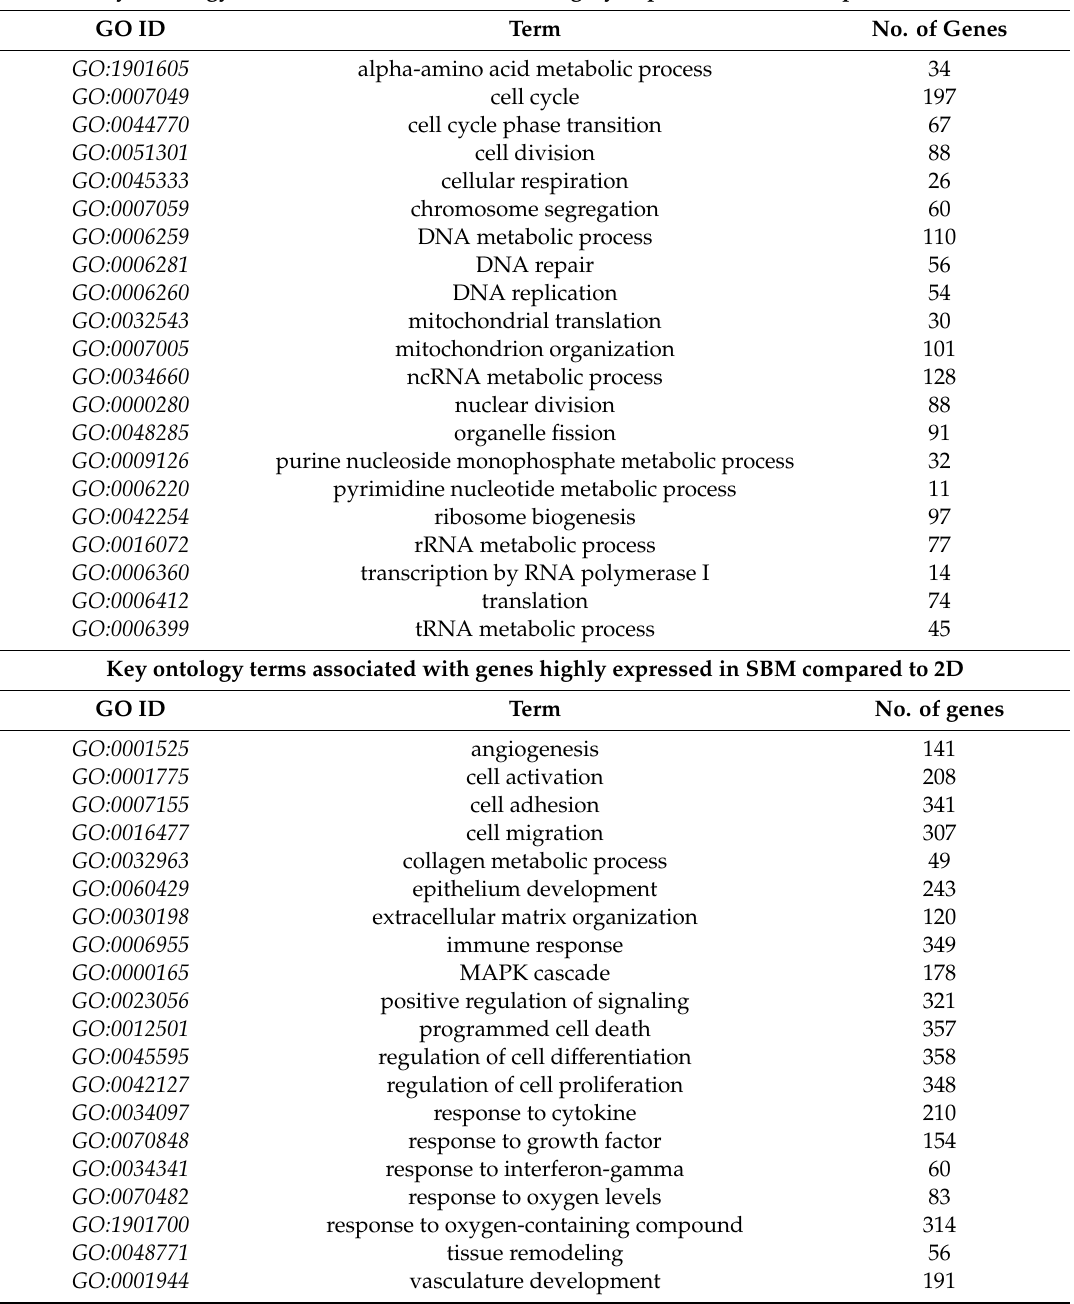
Table 1. Ontologies associated with genes highly expressed in 2D vs. cancer cells isolated from orthotopic and syngeneic 4T1 mouse